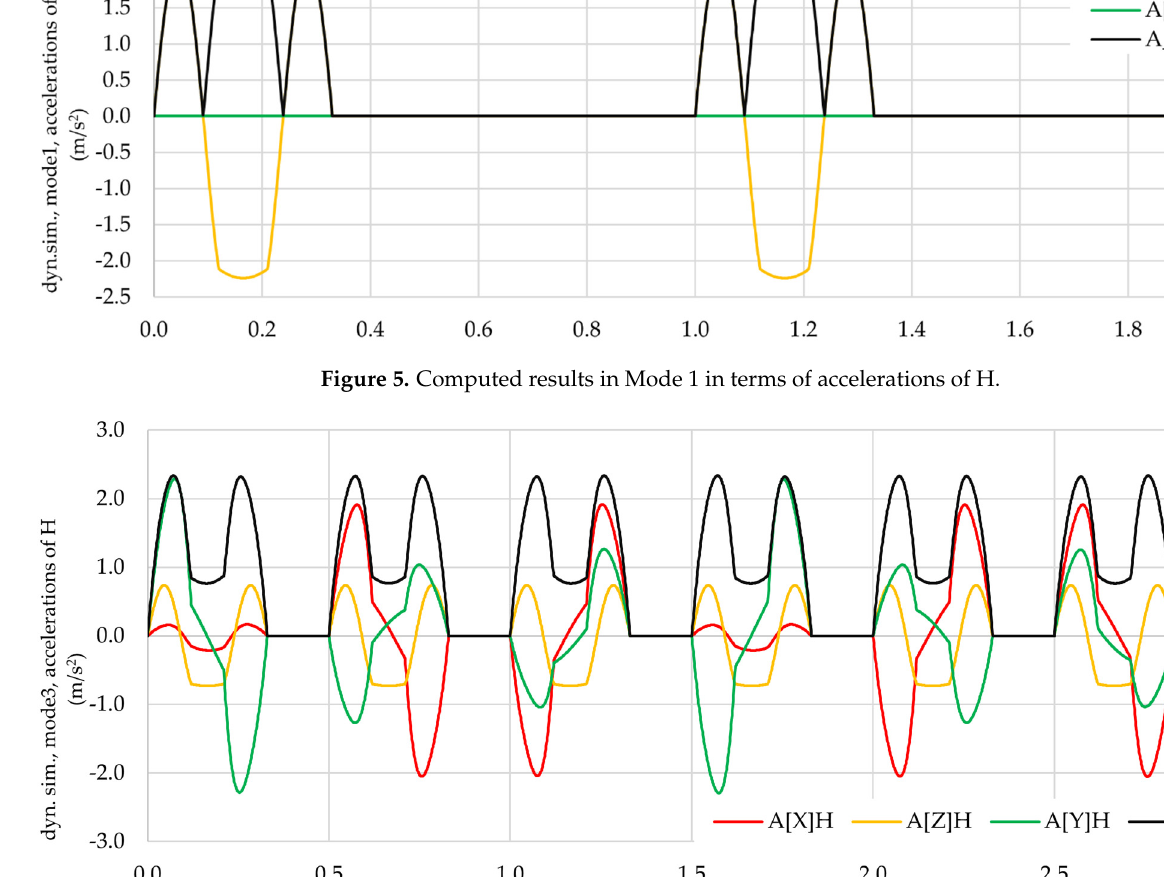
Figure 6. Computed results in Mode 3 in terms of accelerations of H. When the speed is the controlled characteristic, the torque depends on it. Figures 7a,b show the torque values changing during time. The measurements have been done for the first leg, which is placed perpendicularly to X axis.